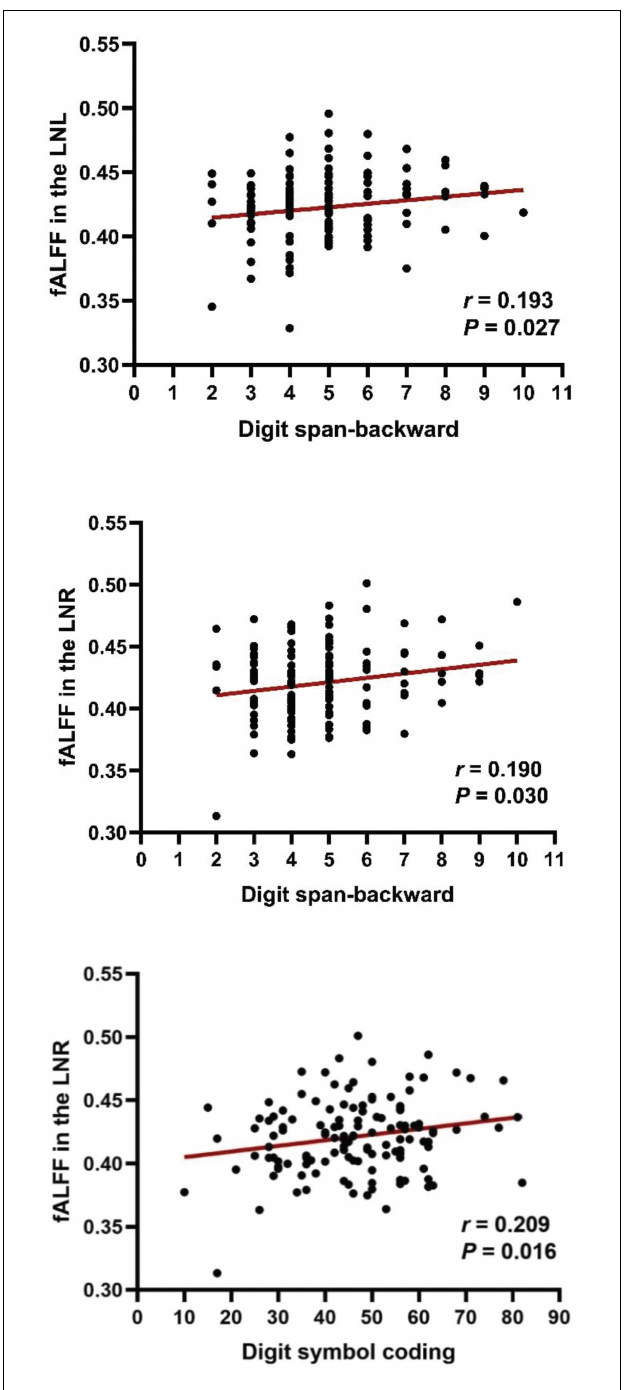
FIGURE 3 | Correlation between fALFF and cognitive impairments in patients with schizophrenia. Digit span-backward test and digit symbol coding were positively correlated with fALFF values in the LN. LNL, left LN; LNR, right